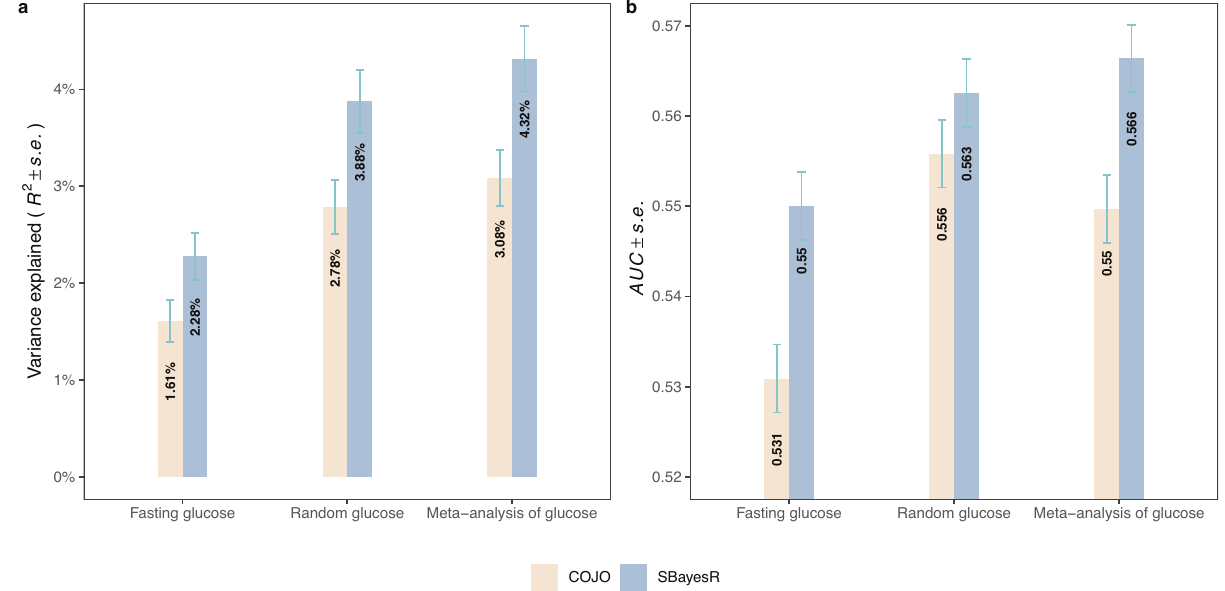
Fig. 3 | Polygenic prediction of Fasting Glucose. Polygenic scores were con- structed using either GCTA-COJO genome-wide signi fi cant SNPs or SBayesR methods,andthestandarderrors( s.e .)werecalculatedusingtheJackknifemethod. a Prediction R 2 when predicting fasting glucose in unrelated, nondiabetic Lifelines samples( N =13,781). b Areaunderthereceiveroperatorcharacteristic(ROC)curve (AUC) when predicting T2D risks in unrelated GERA samples (6905 T2D cases and 46,983 controls). The x-axis indicates the discovery samples used to generate the